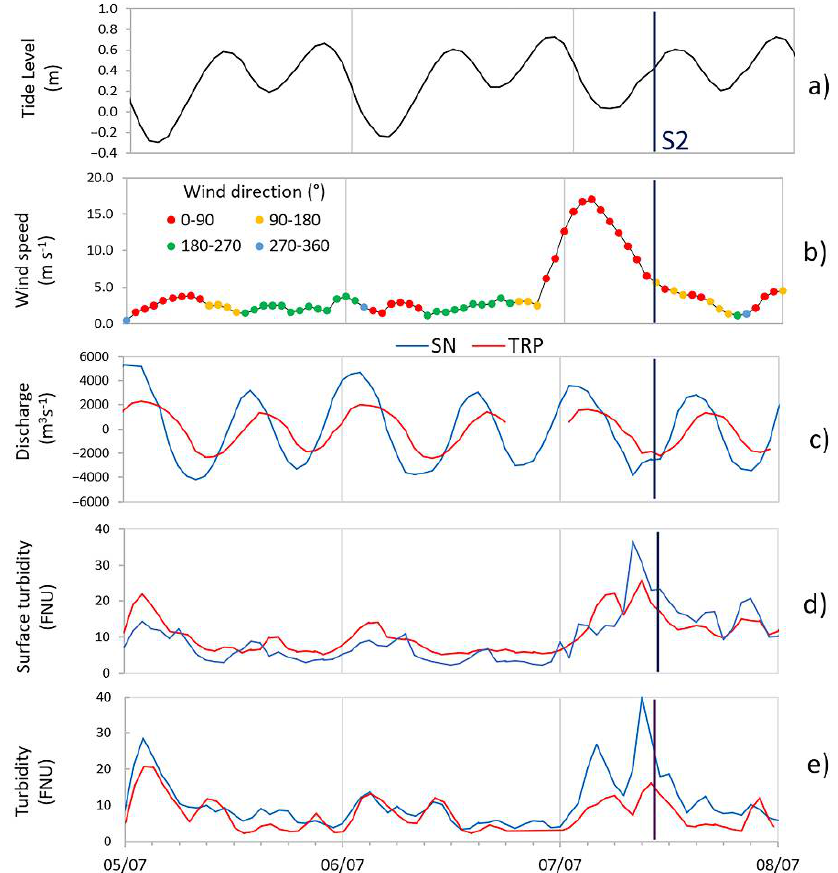
Figure 9. Subset of the time series presented in Figure 7 for the period from 5 to 7 July 2020. Hourly time series of tidal level ( a ) and wind speed and direction (red = 0°–90°, yellow = 90°–180°, green = 180°–270°, cyan = 270°–360°) ( b ), measured at the Lido Sud station; time series of discharge estimated with the index-velocity method from data of the bottom-mounted ADCPs (positive values of discharge indicate a seaward flow) ( c ); time series of surficial turbidity measured at fixed TRP and SN stations ( d ); and the vertically averaged turbidity derived from the conversion of acoustic backscatter from the bottom-mounted ADCPs ( e ). Vertical blue line marks the S2 satellite overpass time.